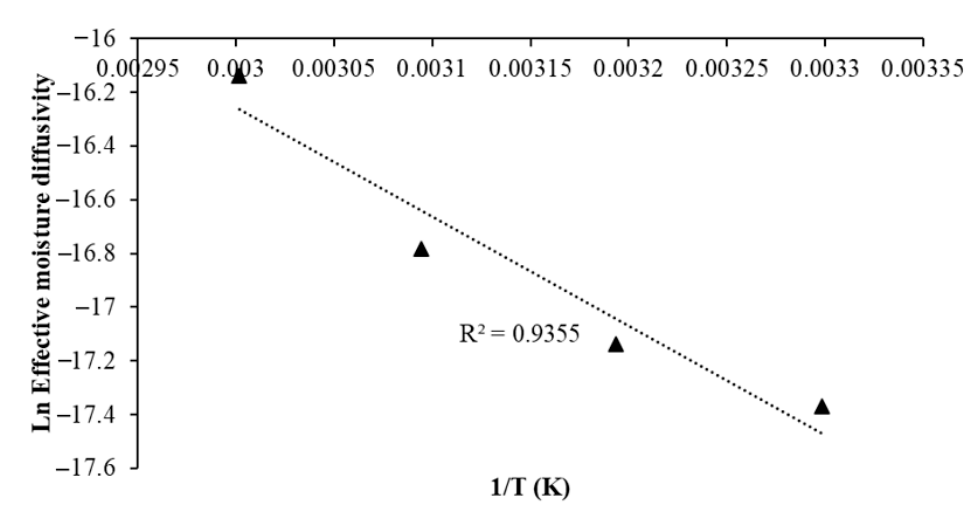
Figure 4. Logarithmic of effective moisture diffusivity versus absolute temperature (1/T, K) of Kyoho skin.